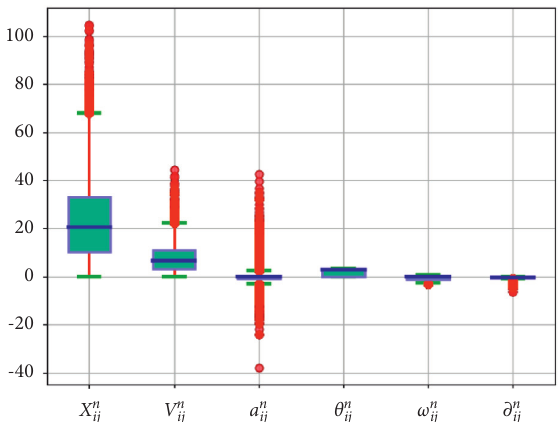
Figure 8: Box diagram of vehicle behavior in the vehicle entry